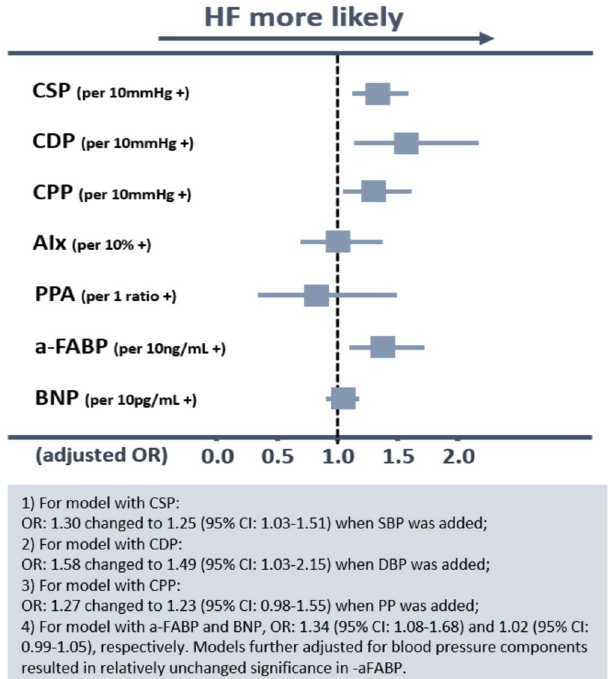
Figure 3. Predictors of heart failure hospitalization. When history of heart failure (HF) was incorporated into the models, all central hemodynamic indices, except AIx, and a-FABP remained as independent predictors for incident HF. Models were adjusted for clinical co-variates as: age, sex, body mass index, and known history of heart failure, hypertension, diabetes, coronary artery disease, hyperlipidemia medication use, and renal function (eGFR). Abbreviations as Table